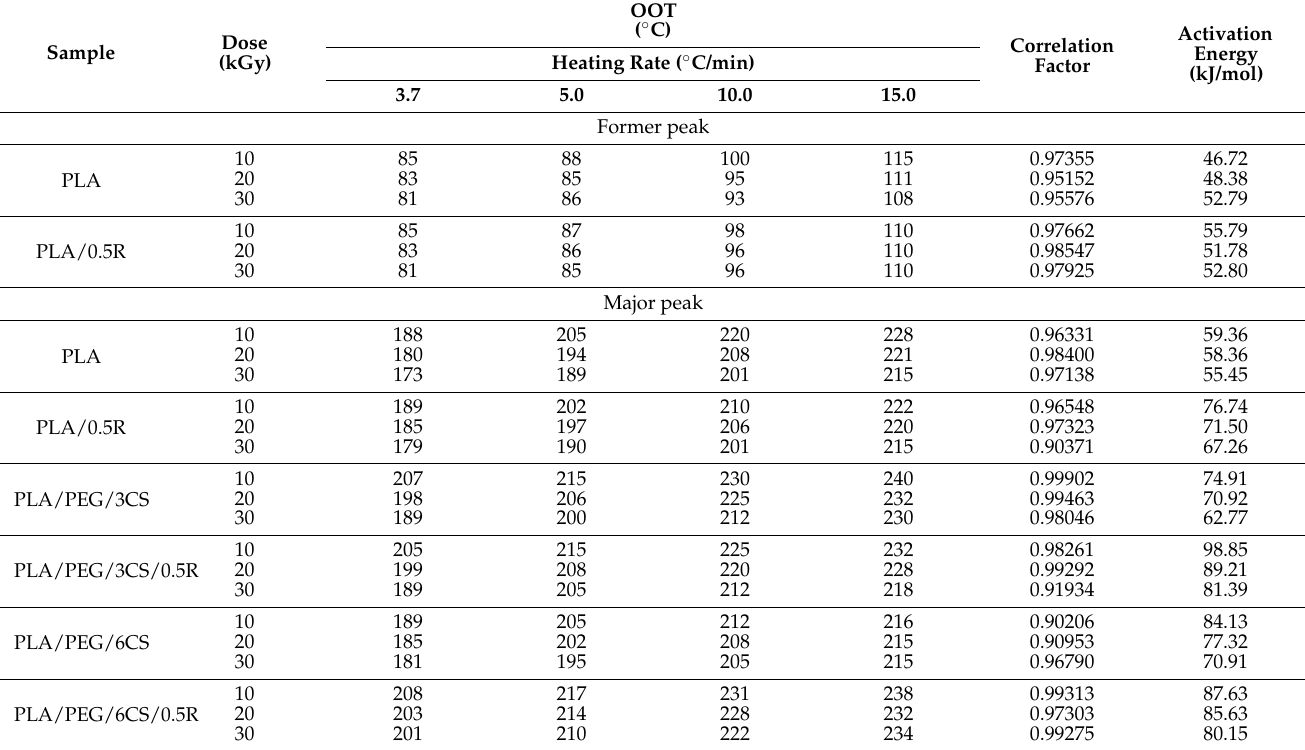
Table 4. Onset degradation/oxidation temperature (OOT) and activation energies of irradiated biocomposites.